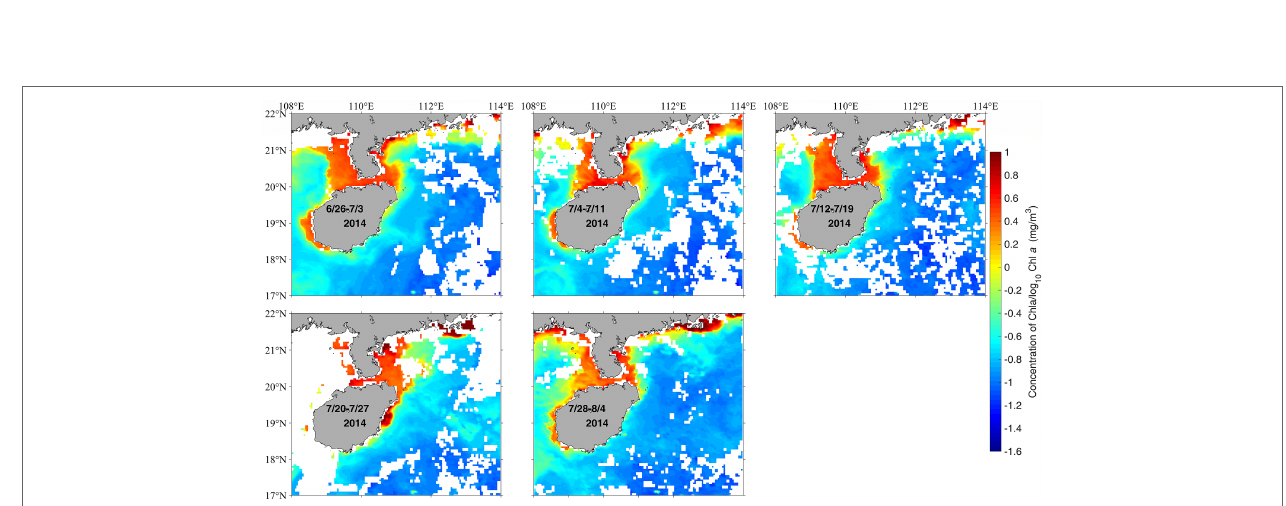
FIGURE 4 | Distribution of MODIS 8-day averaged Chl-a (mg m -3 ) from June 26 to August